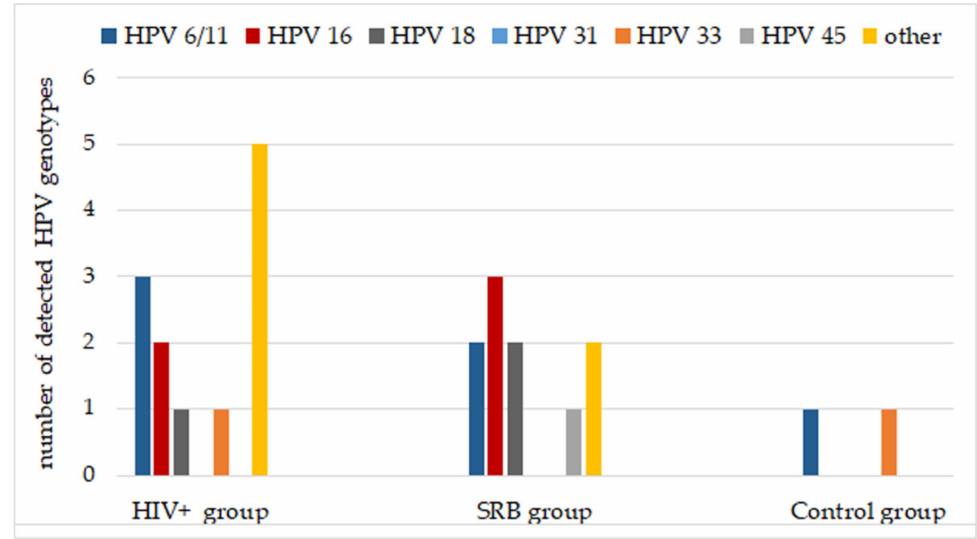
Figure 2. Genotype characterization of the HPV-positive